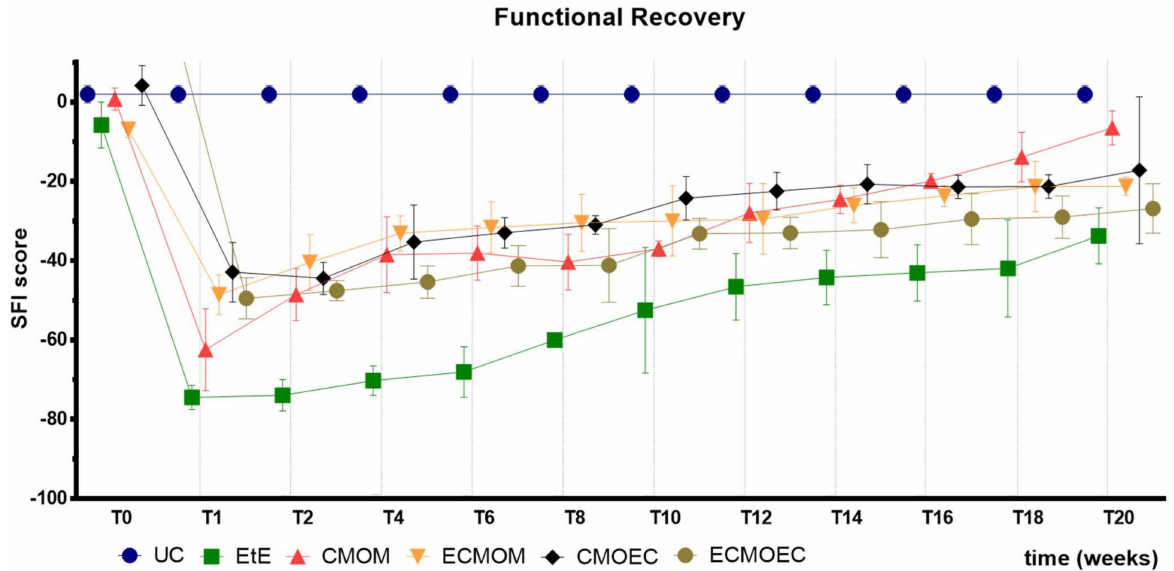
Figure 7. Functional assessment (SFI) over the 20-week recovery period (mean ± SEM). After the neurotmesis injury, a significant impairment of the hind limb was observed in all intervened groups. After week 1, a progressive improvement in SFI was observed in all therapeutic groups, and at the final timepoint, the CMOM group was the one with the best functional index values.